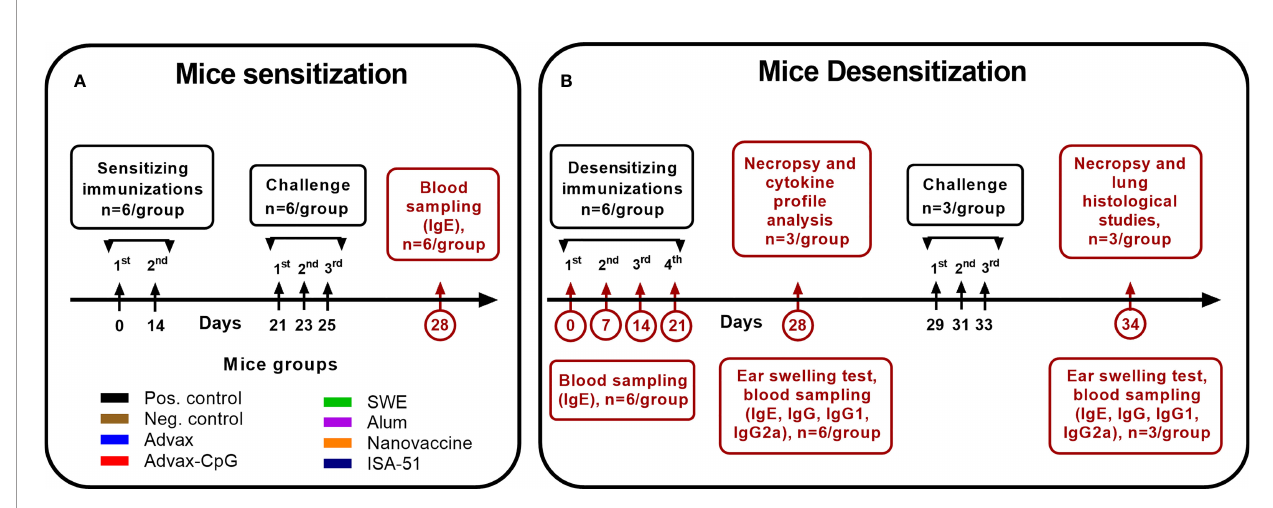
FIGURE 1 | Experimental design. The scheme of sensitization (A) of mice by wormwood pollen extract and their desensitization (B) with vaccine formulations based on recombinant Art v 1 protein and various adjuvants, as well as wormwood pollen extract challenges, is depicted.